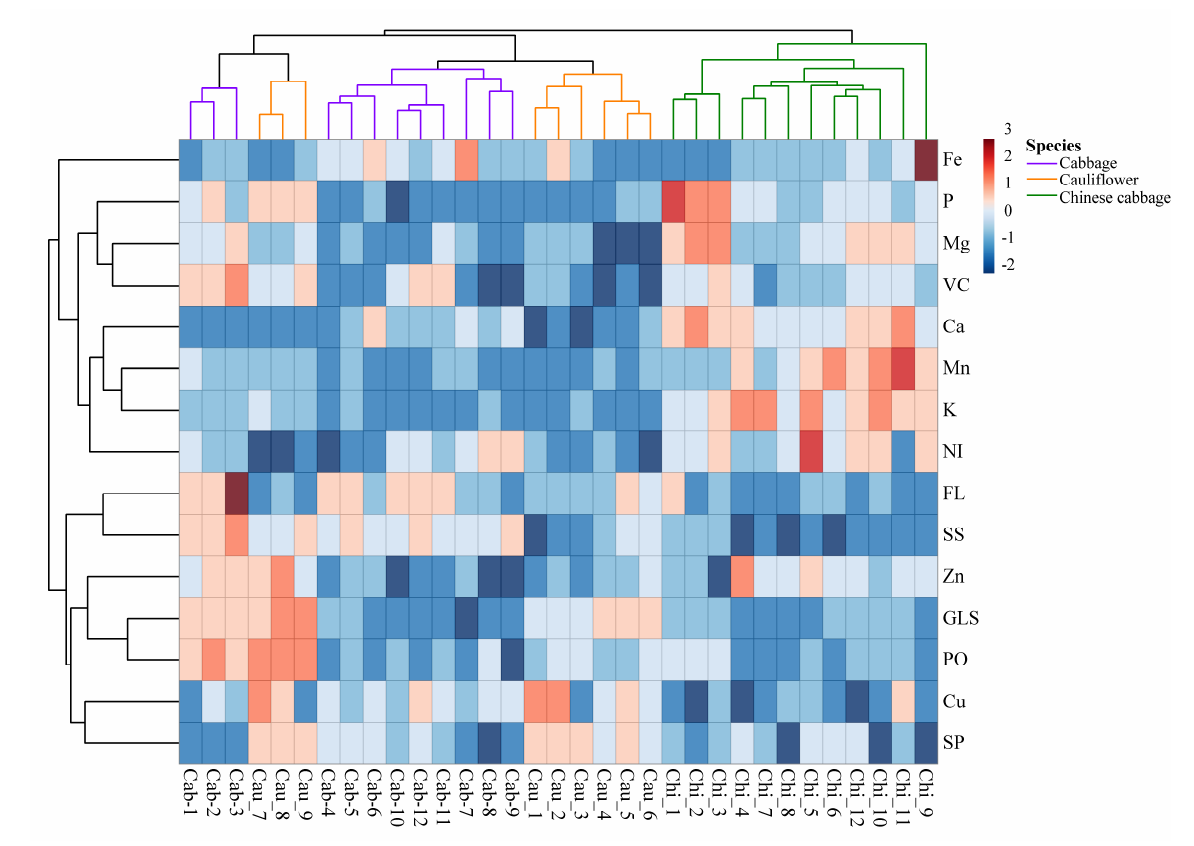
Figure 4. Heatmap representing the hierarchical clustering of the 33 varieties studied based on their leaf ball and curd composition profiles. Columns represent the varieties, and rows represent the traits evaluated. Unit variance scaling was applied to rows. Both rows and columns are clustered using correlation distance and average linkage. The scale of the color intensity is shown in the top right corner, and it represents a proportional value of the compound content. The full definition for each trait abbreviation can be found in Table 3.